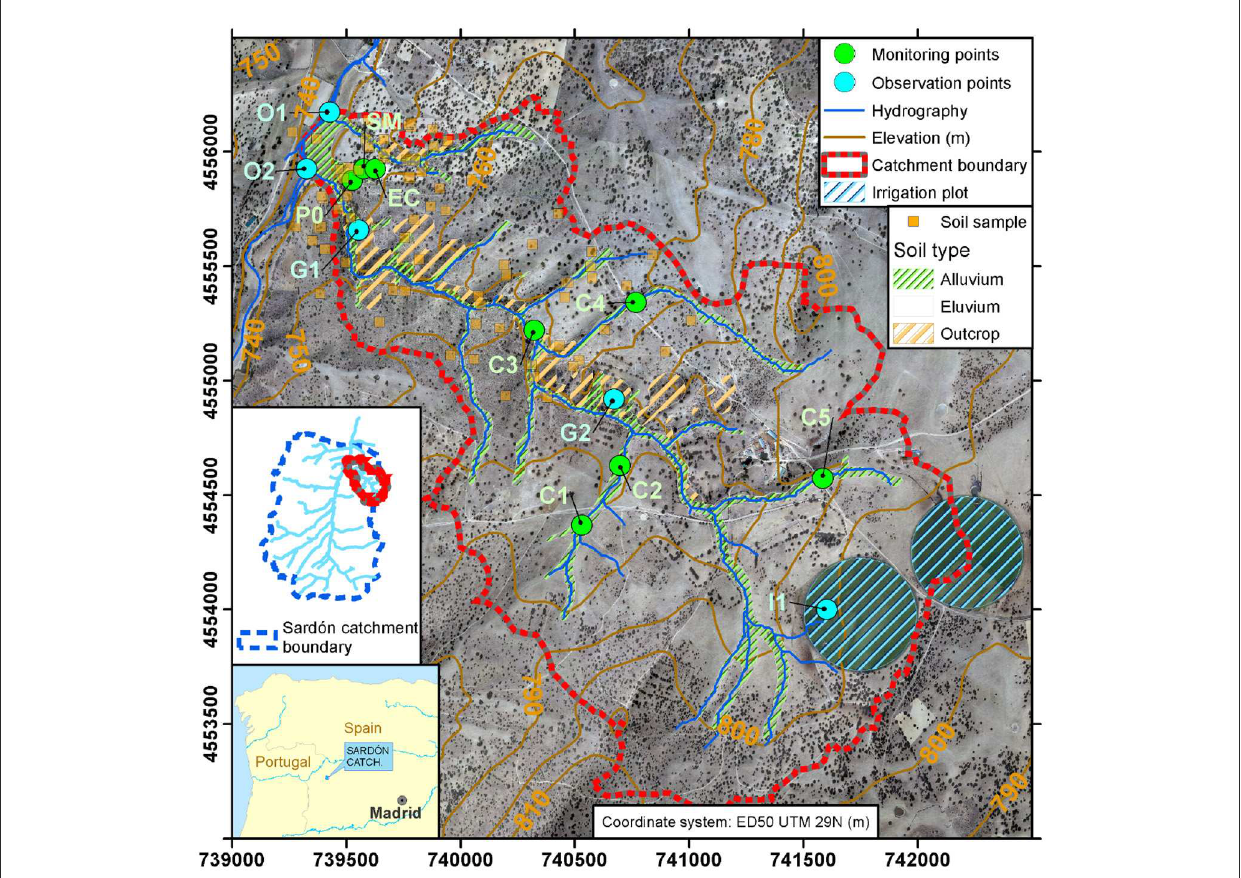
FIGURE1 La Mata sub-catchment. Labels indicate monitoring and observation points: G-points in granite outcrops, I-points in irrigation plots and O-points at the outlet.